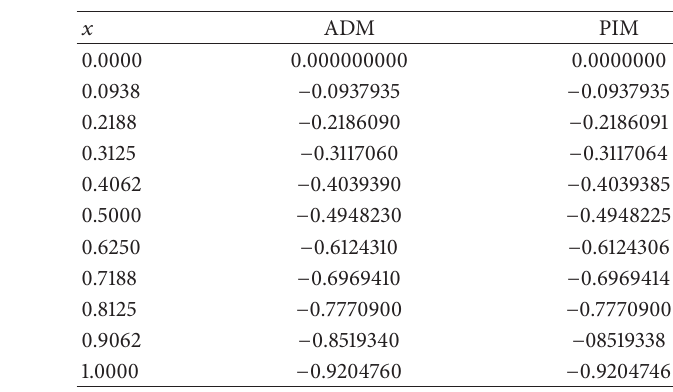
Table 1: The results of Example 1 for 𝑢 3 (𝑥) with ℎ = −1